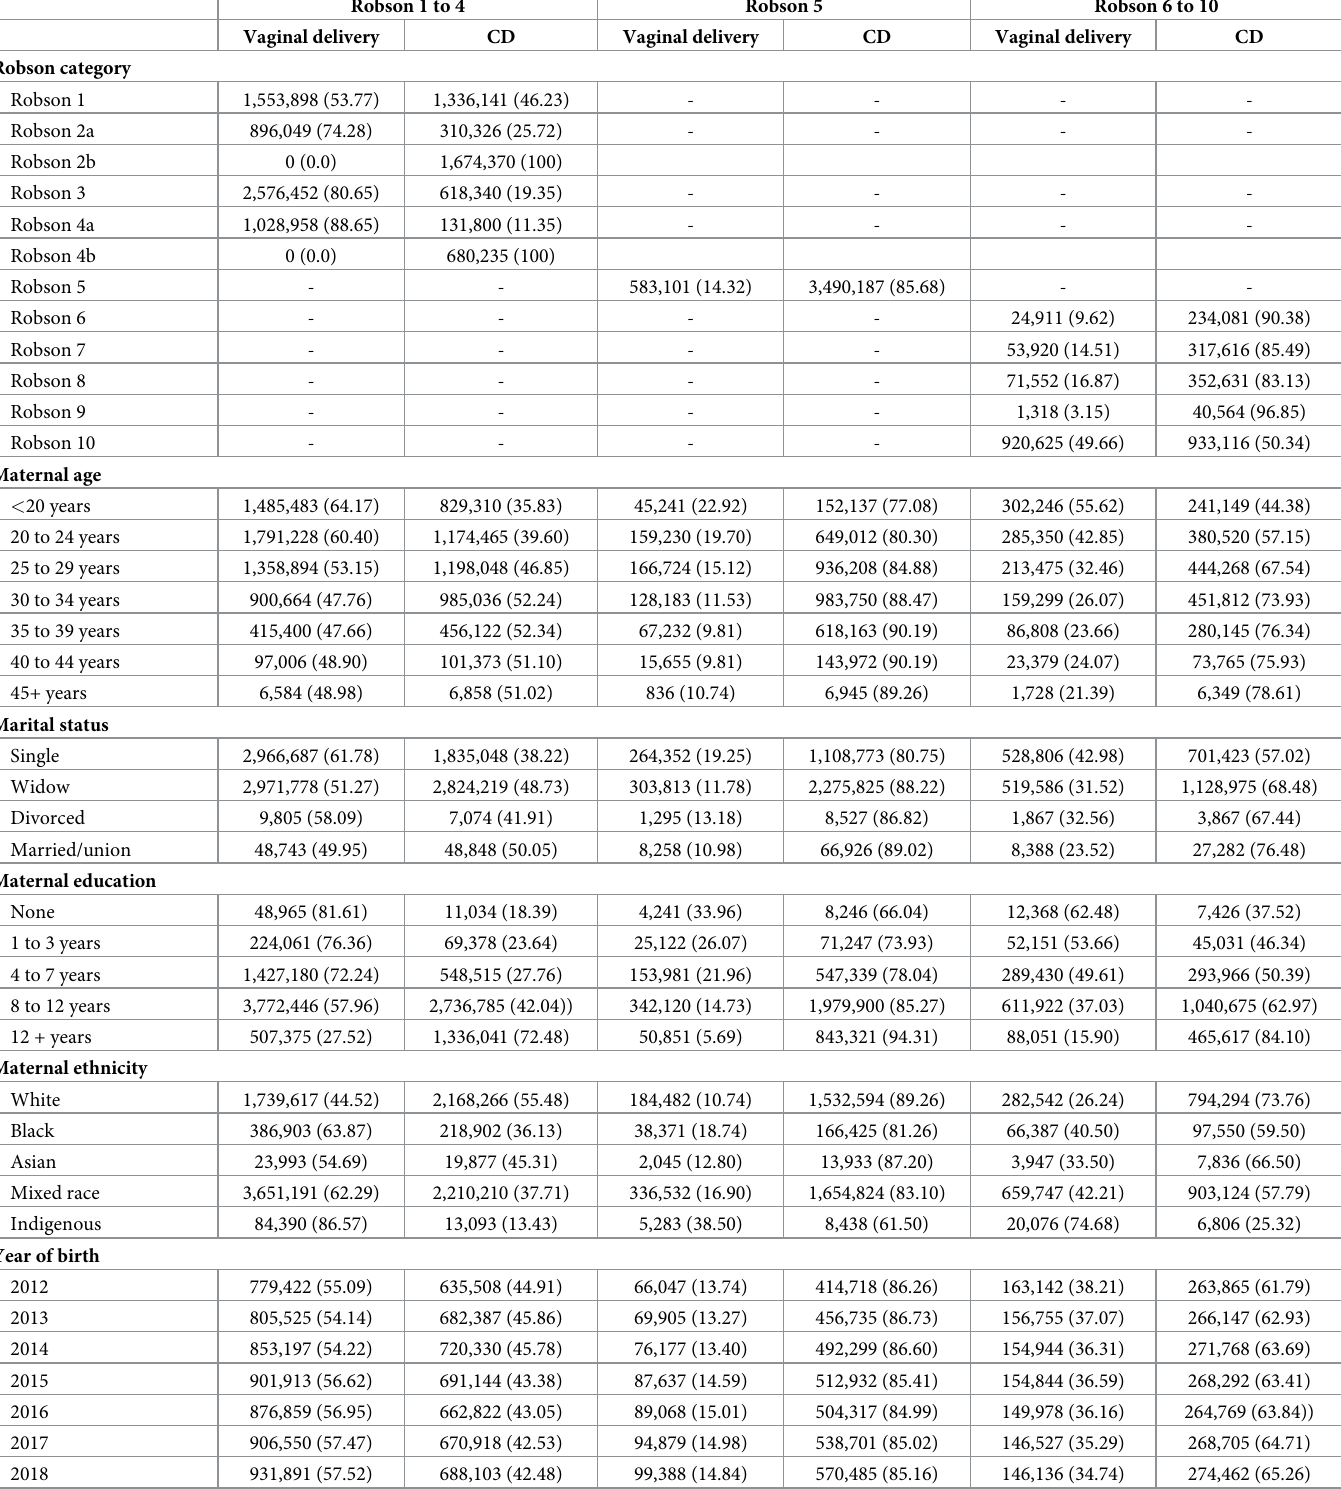
Table 2. Characteristics (number and percent) of 17,838,115 live births deliveries in Brazil from 2012 to 2018 by mode of